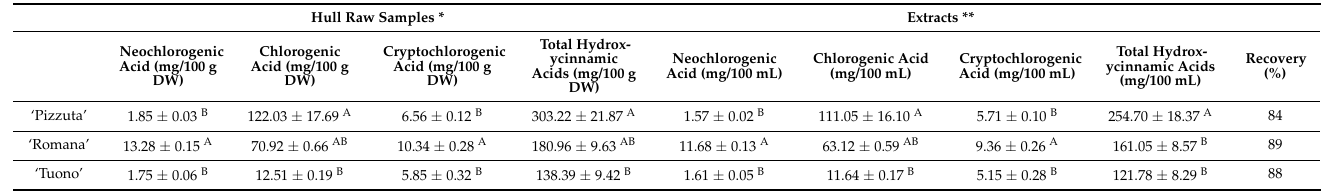
Table 2. HPLC-PDA analysis of hydroxycinnamic acids in ‘Pizzuta’, ‘Romana’ and ‘Tuono’ hull raw samples (H) and extracts